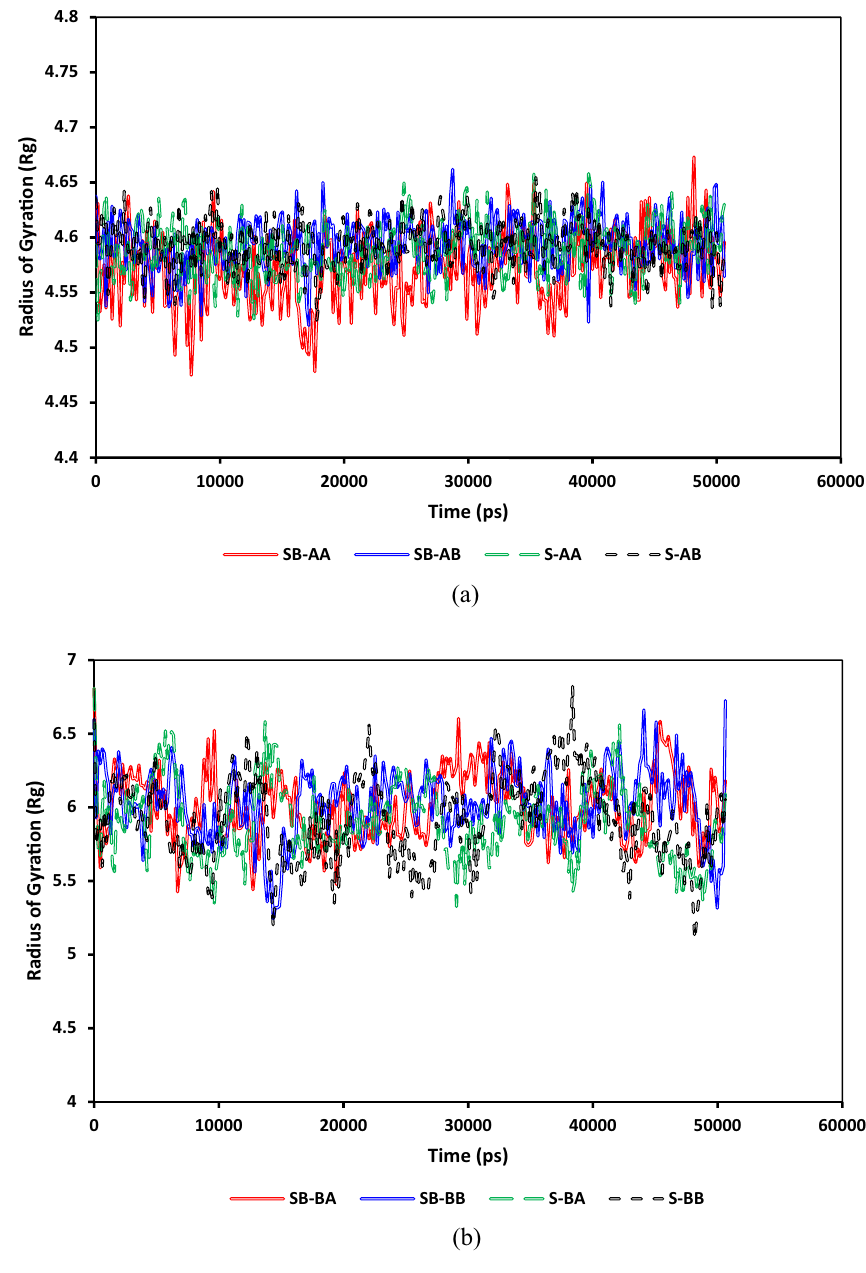
Figure 12. Comparison between the radii of gyration of ( a ) C 40 H 30 O 2 and ( b ) C 44 H 40 N 2